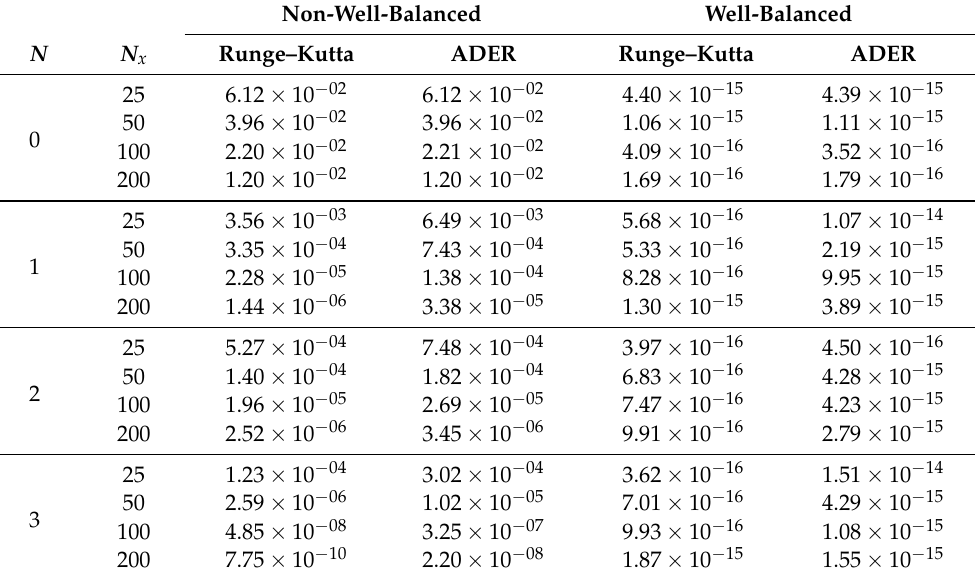
Table 4. Numerical validation of the well-balanced and non well-balanced methods for the stationary problem (51) (shallow water equations). Table contains L 1 errors for the conserved variable hu at a final time t = 10 s for Runge–Kutta and ADER DG schemes of order N + 1 = 1, 2, 3, 4. Uniform Cartesian meshes of N x elements has been